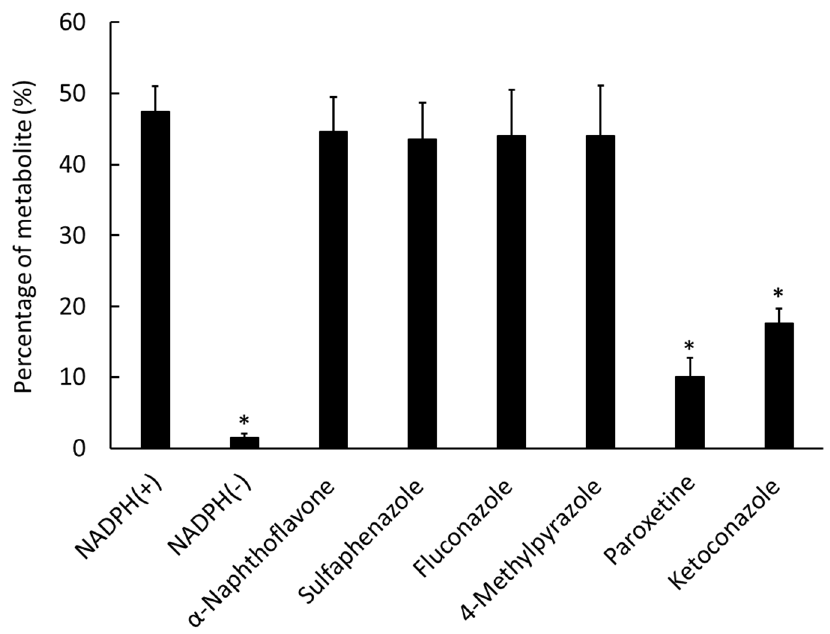
Figure 5. Effect of CYP inhibitors on the metabolism of 125 I-ODV. The percentage of the metabolite was determined using mouse liver microsomes. With NADPH [ − ], paroxetine, and ketoconazole, the metabolite of 125 I-ODV significantly decreased compared with NADPH [+]. * p < 0.01 compared with NADPH[+].